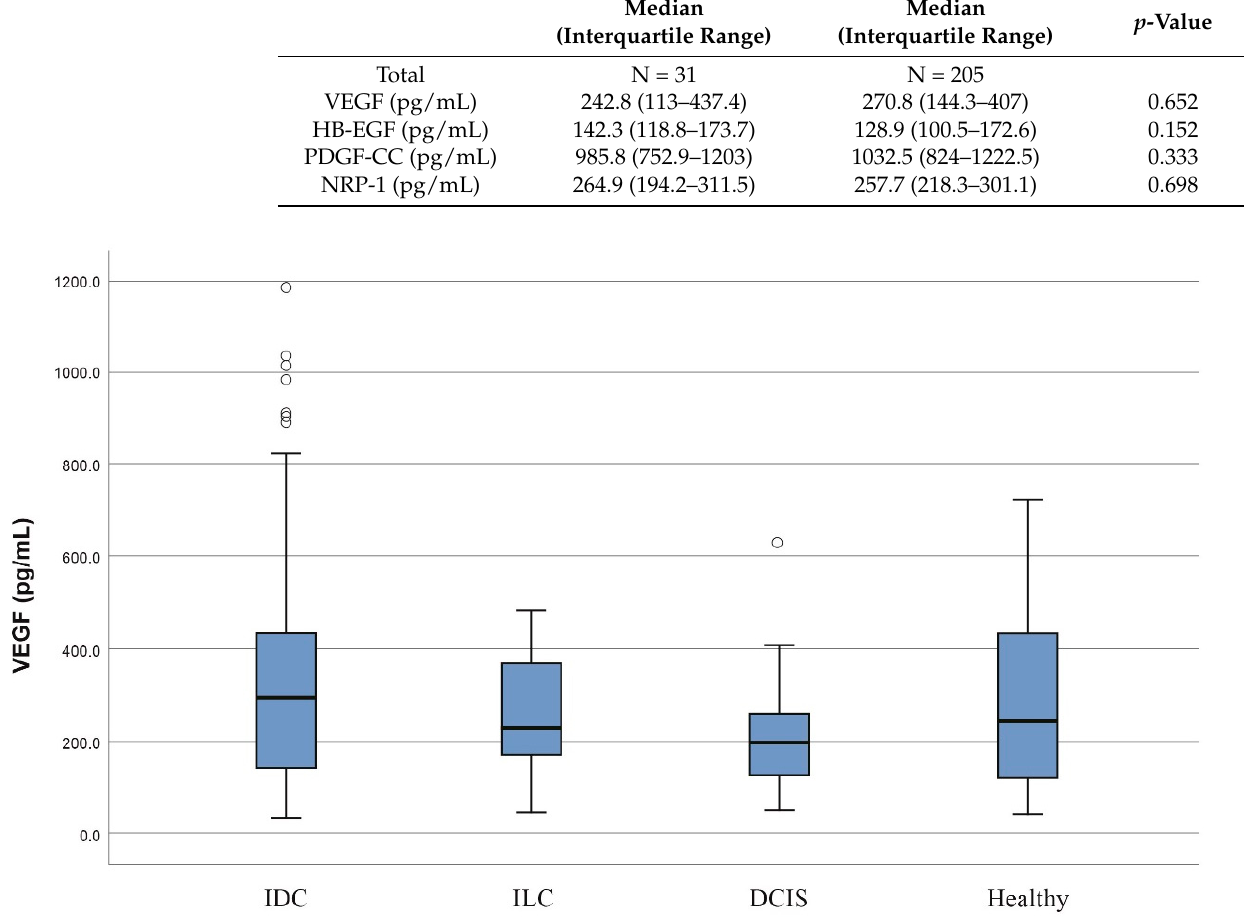
Figure 1. Box plot of serum VEGF levels among patients with different histological types. Serum VEGF levels are significantly higher in invasive ductal carcinoma (IDC) patients compared to ductal carcinoma in situ (DCIS) patients ( p = 0.022). Table 1. Median concentrations (interquartile range) of VEGF, HB-EGF, PDGF-CC and NRP-1 in the serum of the examined patients and healthy women.